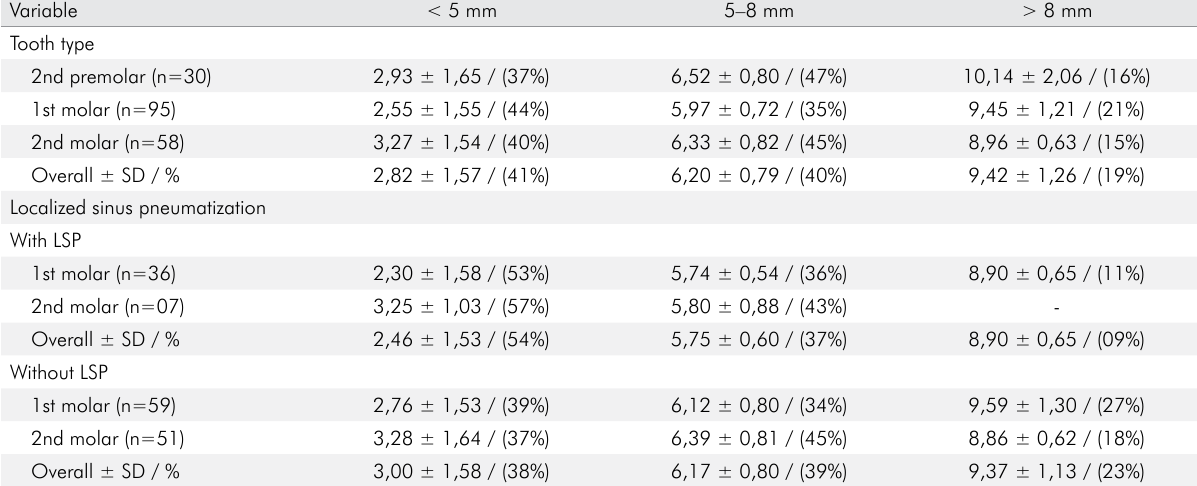
Table 3. Healed Ridge Height (HR) classified as < 5 mm, 5–8 mm and > 8 mm according to tooth type and localized sinus